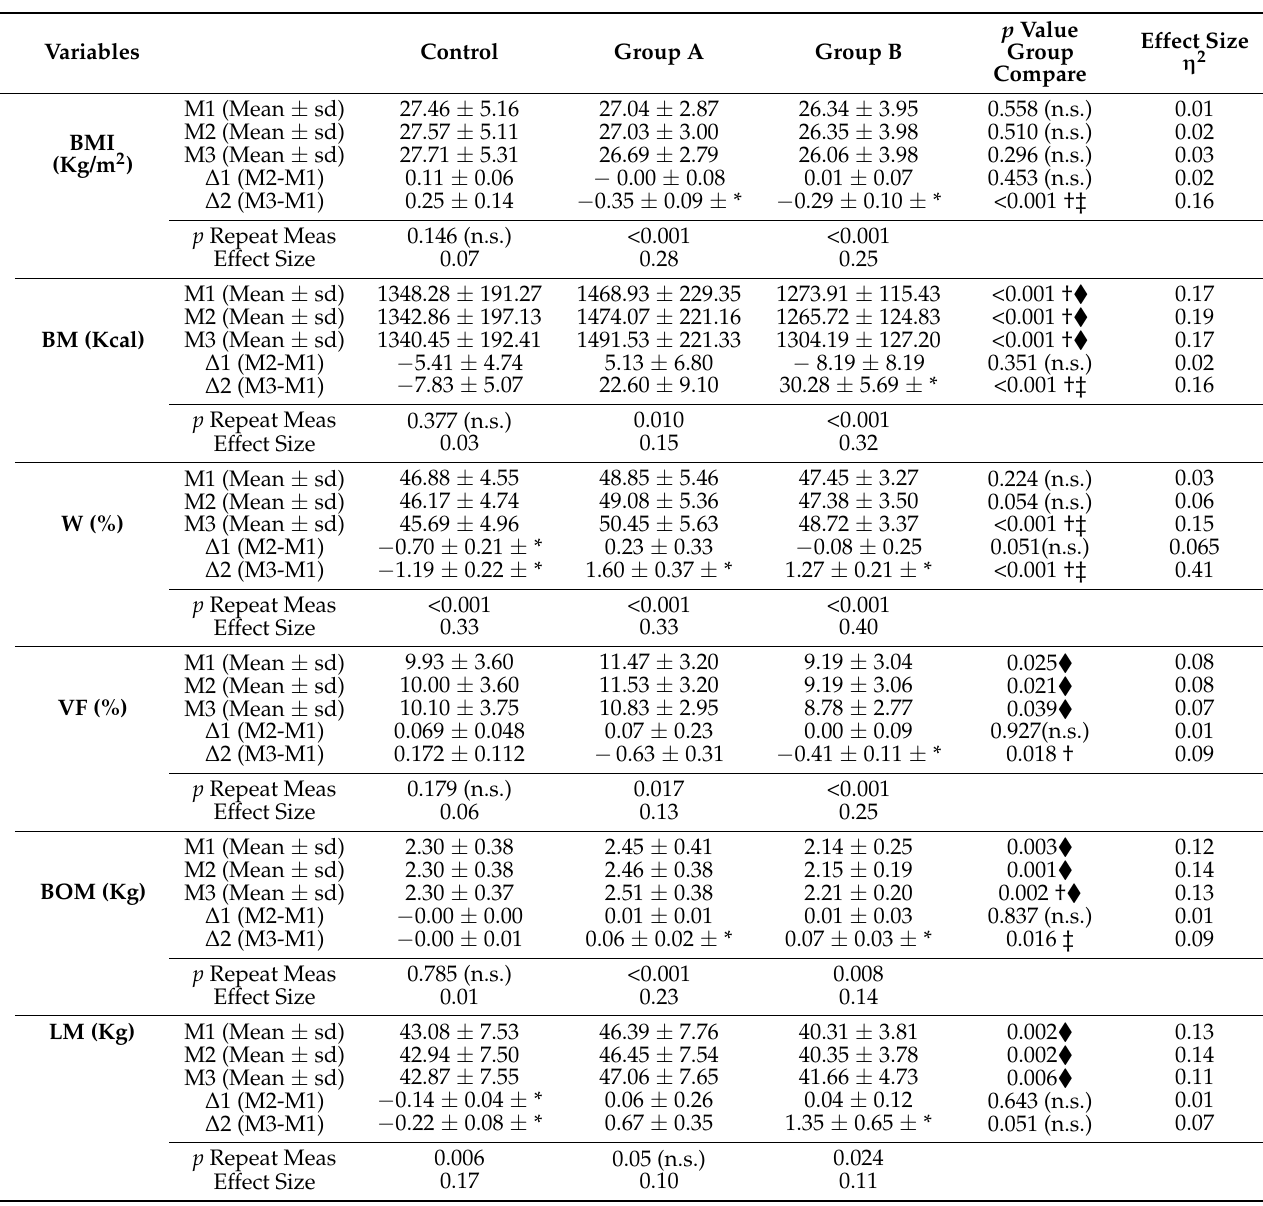
Table 2. Description of body composition, physical fitness in each group in the three moments of the